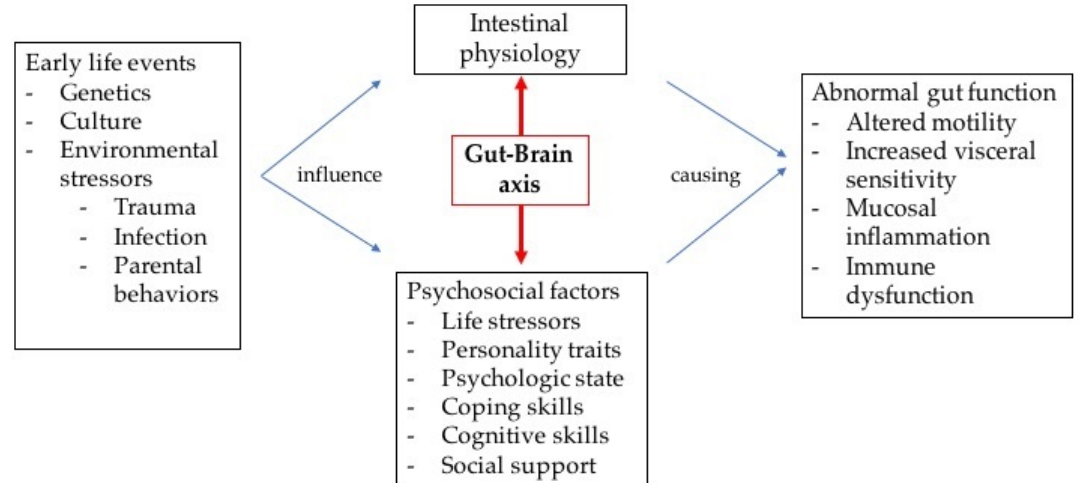
Figure 1. Biopsychosocial approach and gut–brain axis